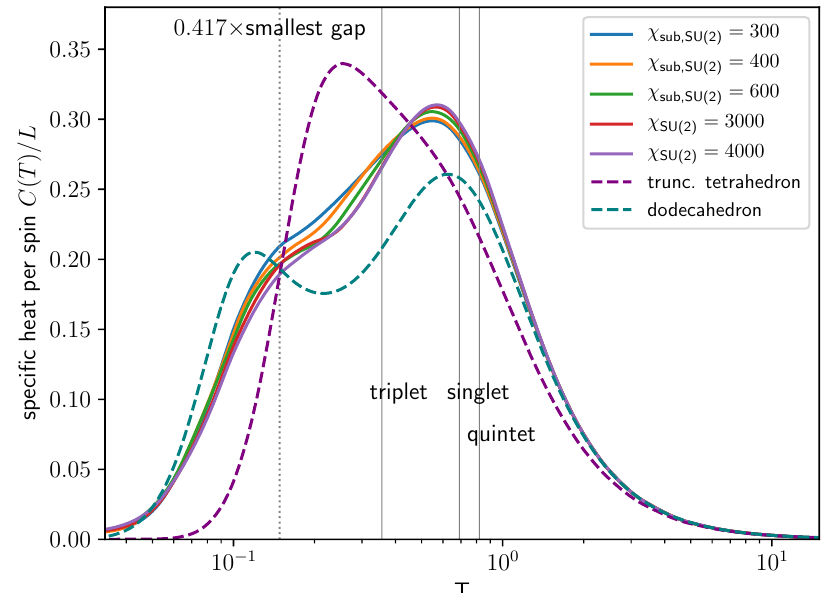
Figure 8: Specific heat of C for different bond dimensions (Eq. 6). The grey ver- 60 tical lines indicate the triplet, singlet and quintet gaps with respect to the ground state. The dotted vertical line indicates 0.417 times the lowest gap (triplet). For the parameters, compare Tab.